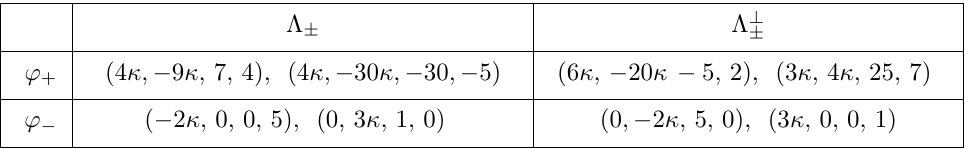
Table 10 . Generators for the lattices (cid:3) (cid:6) and (cid:3) ?